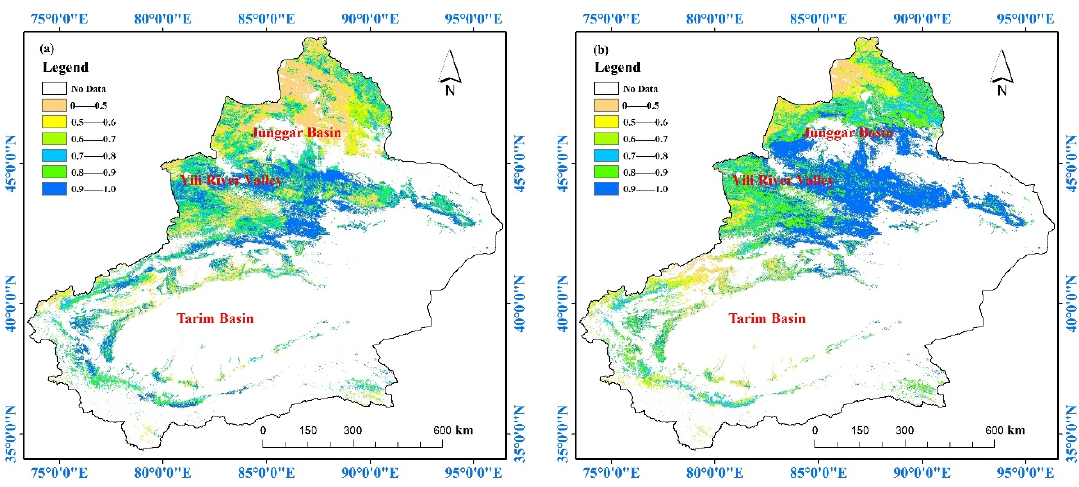
Figure 5. Spatial distribution of Hurst index in Xinjiang from 2000 to 2014.( a ) E ; ( b ) Ep .